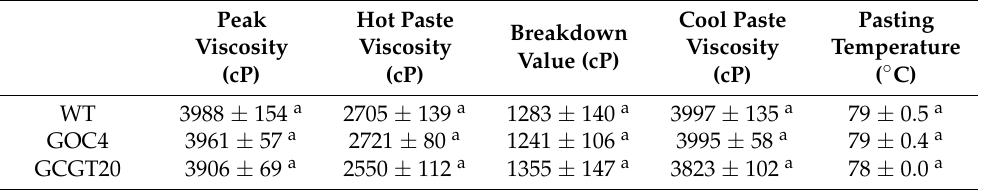
Table 1. Starch viscosity parameters of GOC4, GCGT20, and WT rice grains.